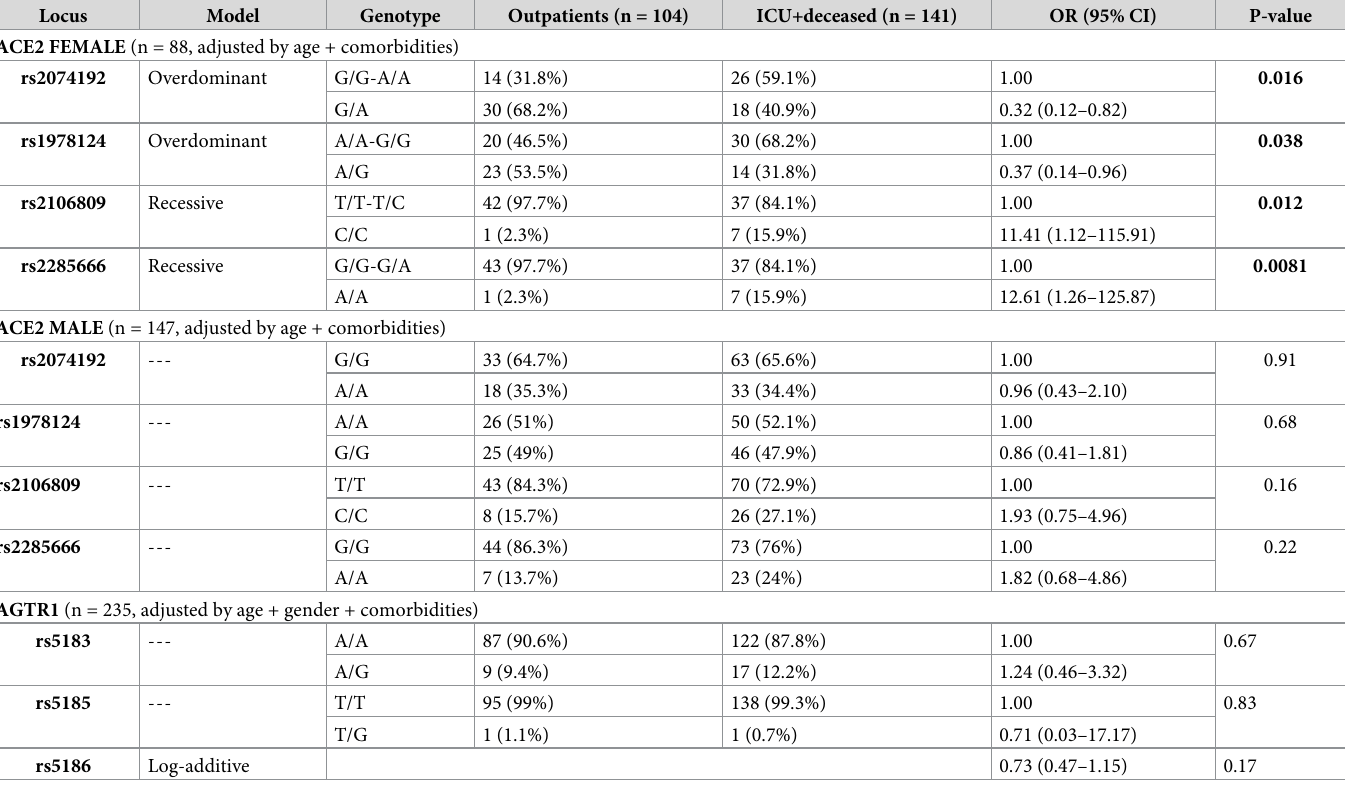
Genotype- and allele type-specific risks obtained in the best model of inheritance based in Akaike information criterion (AIC). OR, odds ratio; CI, confidence interval; ICU, intensive care unit; SNPs, single nucleotide